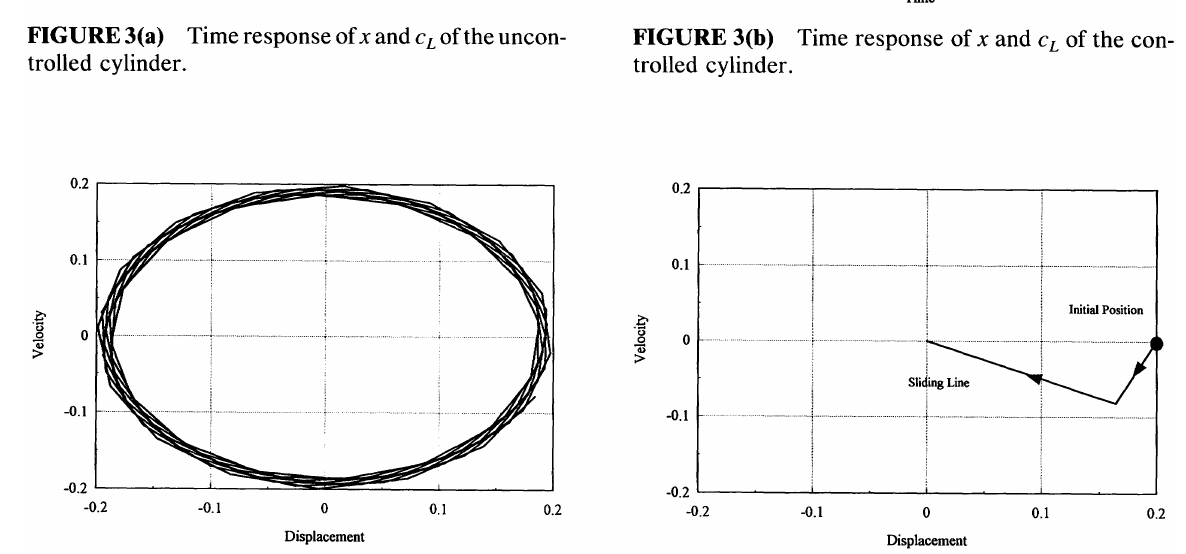
FIGURE 3(a) Time response ofx and CL of the uncon trolled cylinder.